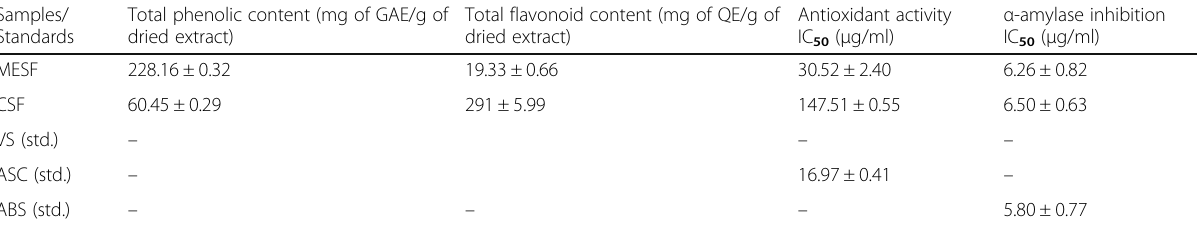
Table 1 Total phenolic content, total flavonoid content, antioxidant, and α -amylase inhibitory activity of various soluble fractions of the crude extract of N.cadamba Samples/ Standards